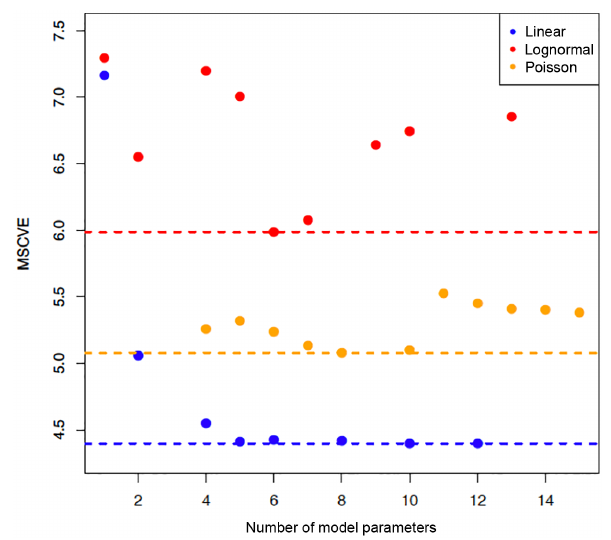
Figure 4. Results of the iterative procedure to optimize the regres- sion model. Increasing the penalty term for additional predictors leads to a model with smaller sets of predictor variables. For each of the resulting predictor sets and the corresponding multiple regres- sion, the mean cross-validation error (MSCVE) is calculated and plotted here. Blue circles represent validation results using a lin- ear regression, orange circles represent results using the lognormal model and red circles represent results using a poisson